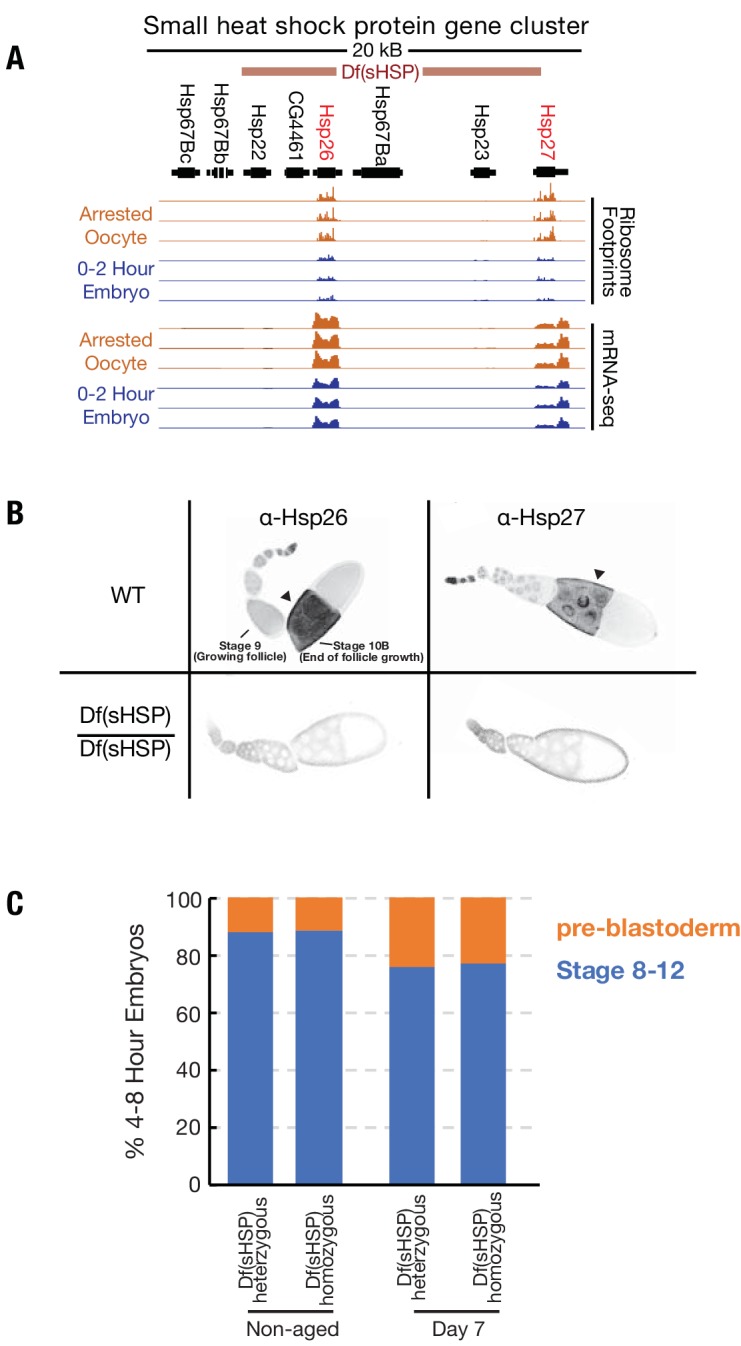
Deletion of the small heat shock protein gene locus.(A) Normalized ribosome footprinting (upper tracks) and mRNA-seq (lower tracks) read depths in the 67B small heat shock protein gene cluster, are compared for replicate experiments from oocytes stored for 2 days (orange) and from 0–2-hr embryos (blue). Above the tracks is a map of the gene cluster, as well as the position of an FRT recombination-induced deletion of all but the left-most two genes that were generated. Two genes, Hsp26 and Hsp27, are transcribed and translated in both stored oocytes and 0–2-hr embryos. (B) Wild type (WT) and Df(sHSP)/Df(sHSP) ovarioles were stained with antibodies specific for Hsp26 and Hsp27. Both genes are expressed during oogenesis and are abundant in later stages (stage 10 shown). However, expression was absent above background in stage 10 follicles from the Df(sHSP)/Df(sHSP) ovarioles. (C) Plot showing similar stage distributions of 4–8-hr embryos derived from non-aged or aged Df(sHSP)/+ or Df(sHSP)/Df(sHSP) oocytes, suggesting that the premature loss of viability of oocytes lacking small heat shock proteins is not due to an acceleration of meiotic spindle defects observed in aged wild type oocytes.